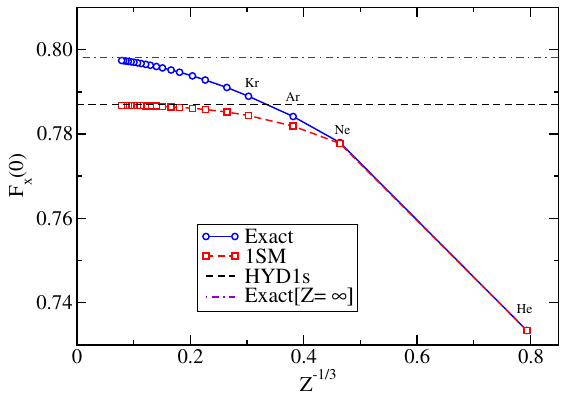
Figure 3. Exchange enhancement factors F x at the nucleus, for the noble atoms (2 ≤ Z ≤ 2022); see the text for